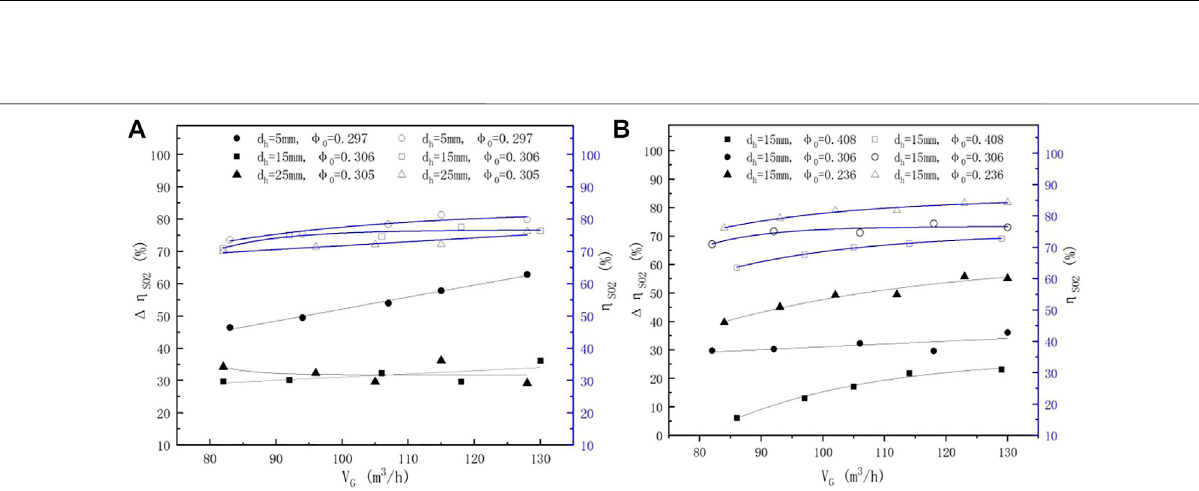
FIGURE 4 | Δη SO2 and η SO2 under different gas fl ow rates (C SO2 = 700 ± 50 mg/m 3 , V L = 1.60 ± 0.05 m 3 /h, and pH = 6), (A) pore diameter, and (B) porosity.